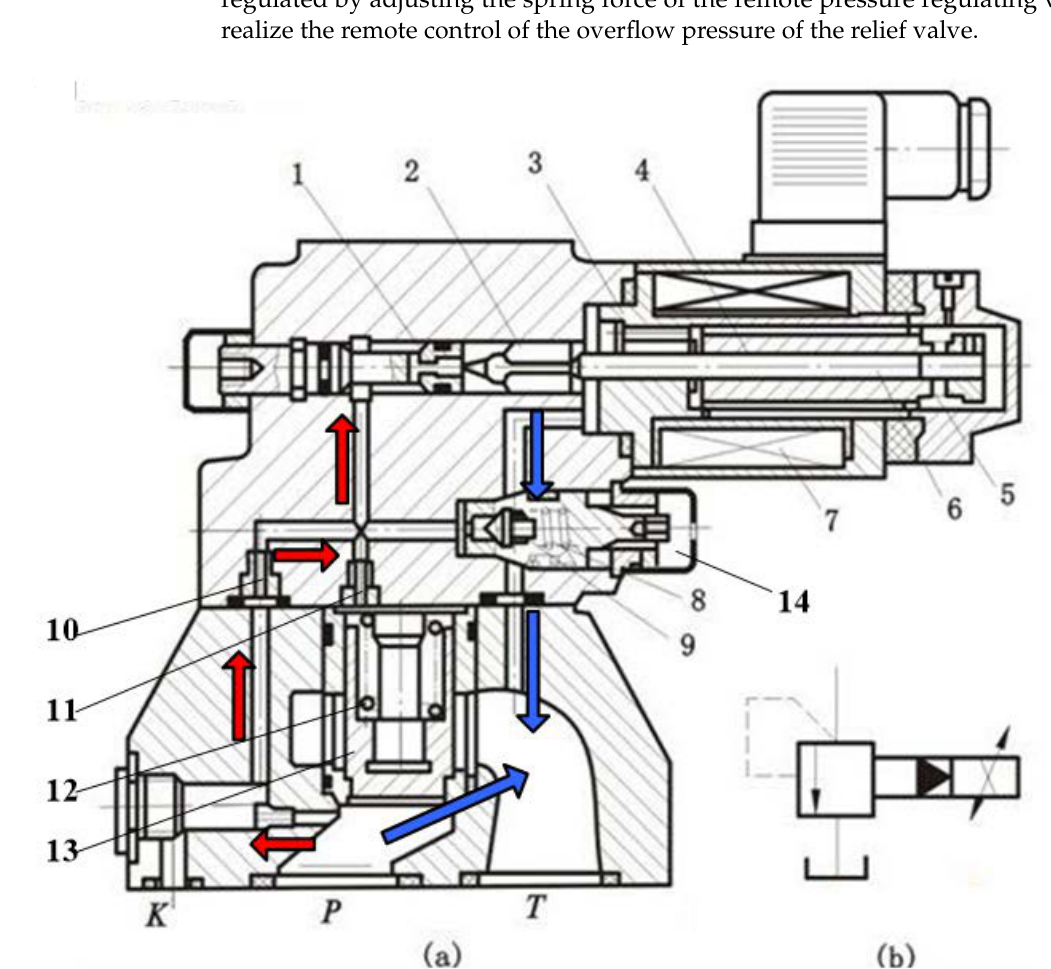
Figure 1. Structure diagram of traditional proportional relief valve. 1—pilot valve seat, 2—pilot poppet valve, 3—yoke; 4—armature, 5—spring; 6—push rod, 7—coil, 8—spring, 9—pilot valve, 10—fixed damping hole, 11—dynamic damping hole, 12—reset spring, 13—main valve core, 14—spring pressure limiting